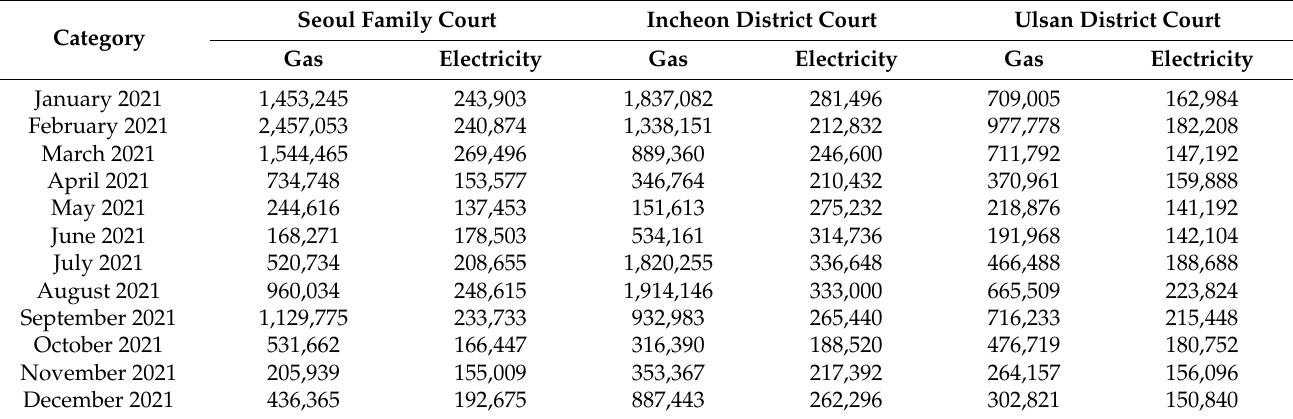
Table 6. Collected energy consumption data (G-SEED non-certified and before insulation thickness standard